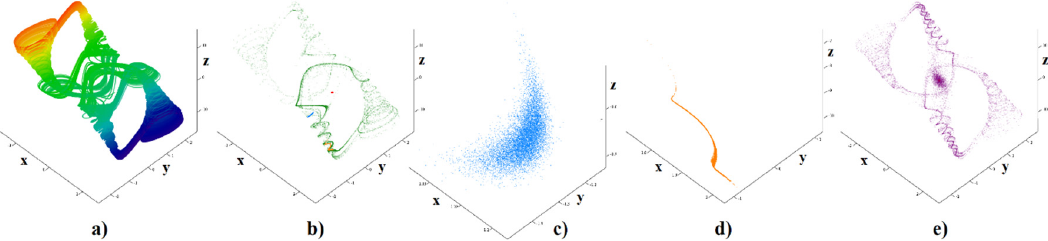
Figure 2. Numerical integration outputs: ( a ) typical double-trumpet chaotic attractor, ( b ) sensitivity to the changes in initial conditions, ( c ) zoomed short time evolution, ( d ) zoomed average time evolution, and ( e ) initial conditions close to point x 0 = (0, 0, 0) T . Note the different scales of the axis system for individual plots.